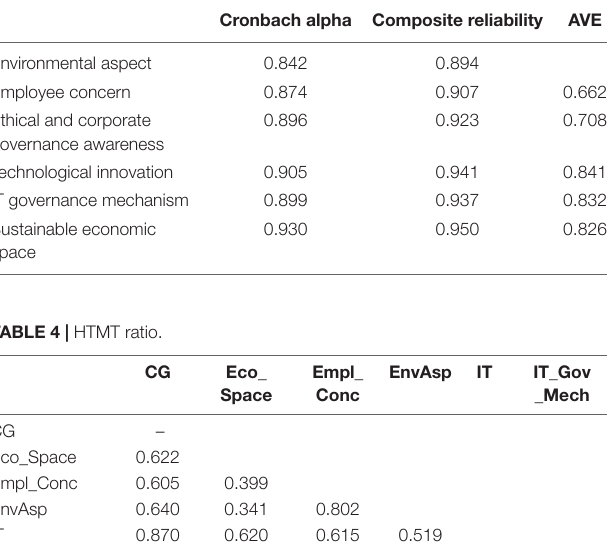
TABLE 3 | Alpha reliabilities and AVE.